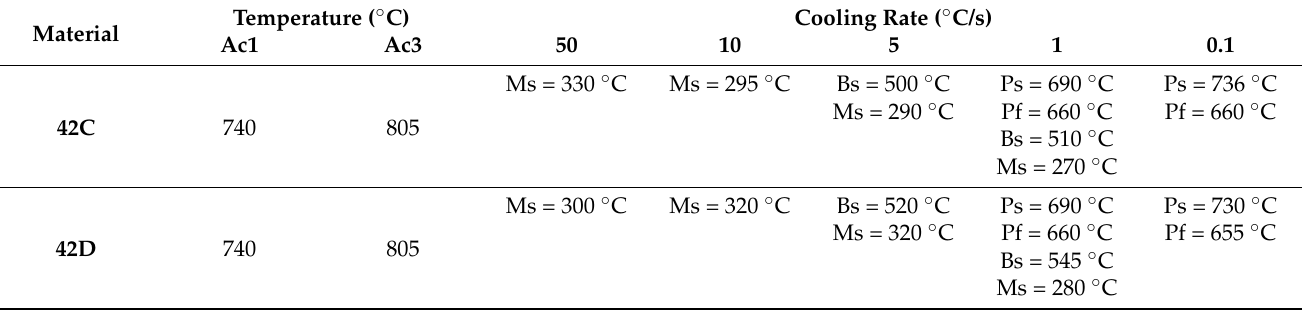
Table 2. Summary of phase transformation temperatures for individual cooling rates measured for 42C and 42D steel. (Ms: martensite start temperature, Mf: martensite finish temperature, B: bainite, P: